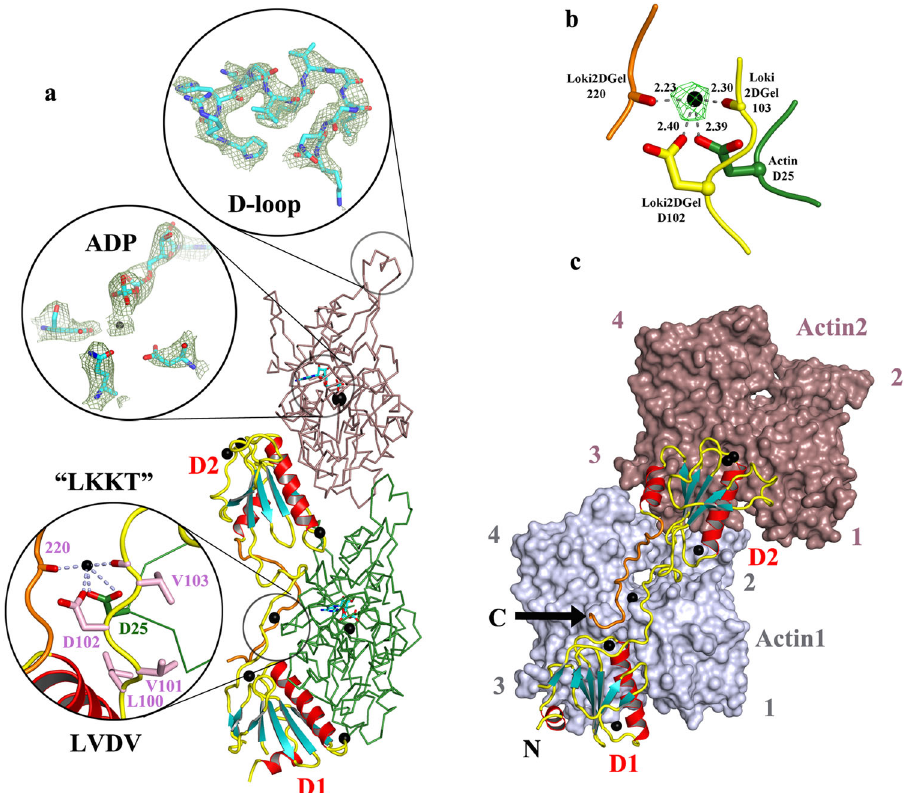
Fig. 2 The Loki2DGel/rActin complex. a Structure of Loki2DGel bound to two copies of rActin (side view). Loki2DGel shown as a cartoon with the ordered portion of the C-terminal extension in orange. Actins are depicted as ribbons (green and brown). The novel calcium-binding site that is coordinated by the Loki2DGel WH2-like motif 24 , C-terminal extension and actin residue Asp25 is highlighted. The OMIT map electron density (contour level 1 σ ) is shown around the D-loop and ADP are also highlighted. Calcium ions are depicted as black spheres. Data collection and re fi nement statistics for this and subsequent structures are found in Table 1. b The calcium-binding site in the WH2-like motif is shown with bonding distances to the calcium ion (Å). The Fo-Fc electron density (contour level 6 σ , peak 8.5 σ ), before the placement of the calcium ion, is shown as a green mesh. c Front view of the Loki2DGel/ actin complex. rActin is shown as surfaces (slate and brown) and Loki2DGel is shown in schematic representation. C and N indicate the C- and N-termini, respectively. Numbers refer to actin